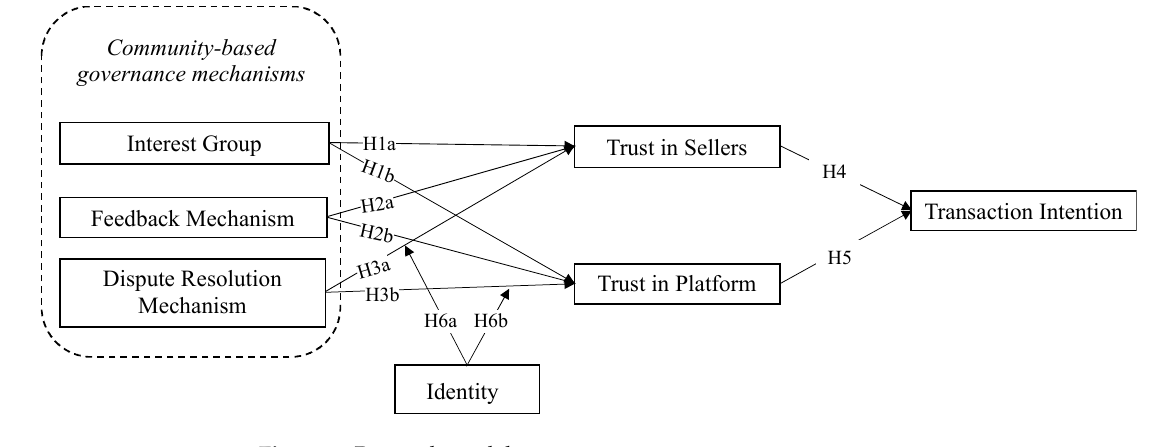
Figure 1. Research model.